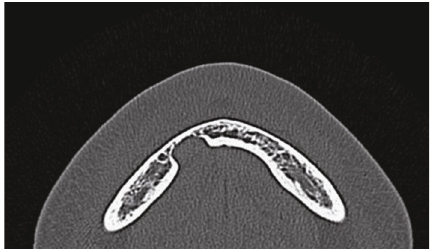
Figure 1: Computed tomography image, horizontal cross section, hard tissue mode. A rounded cavity is observed in the lingual side of the mandible from the right anterior to the premolar region. The margin of the cavity in the lingual side of the mandible is a high-density line, suggesting cortical bone, and is smooth. The mandibular canal is not connected with the